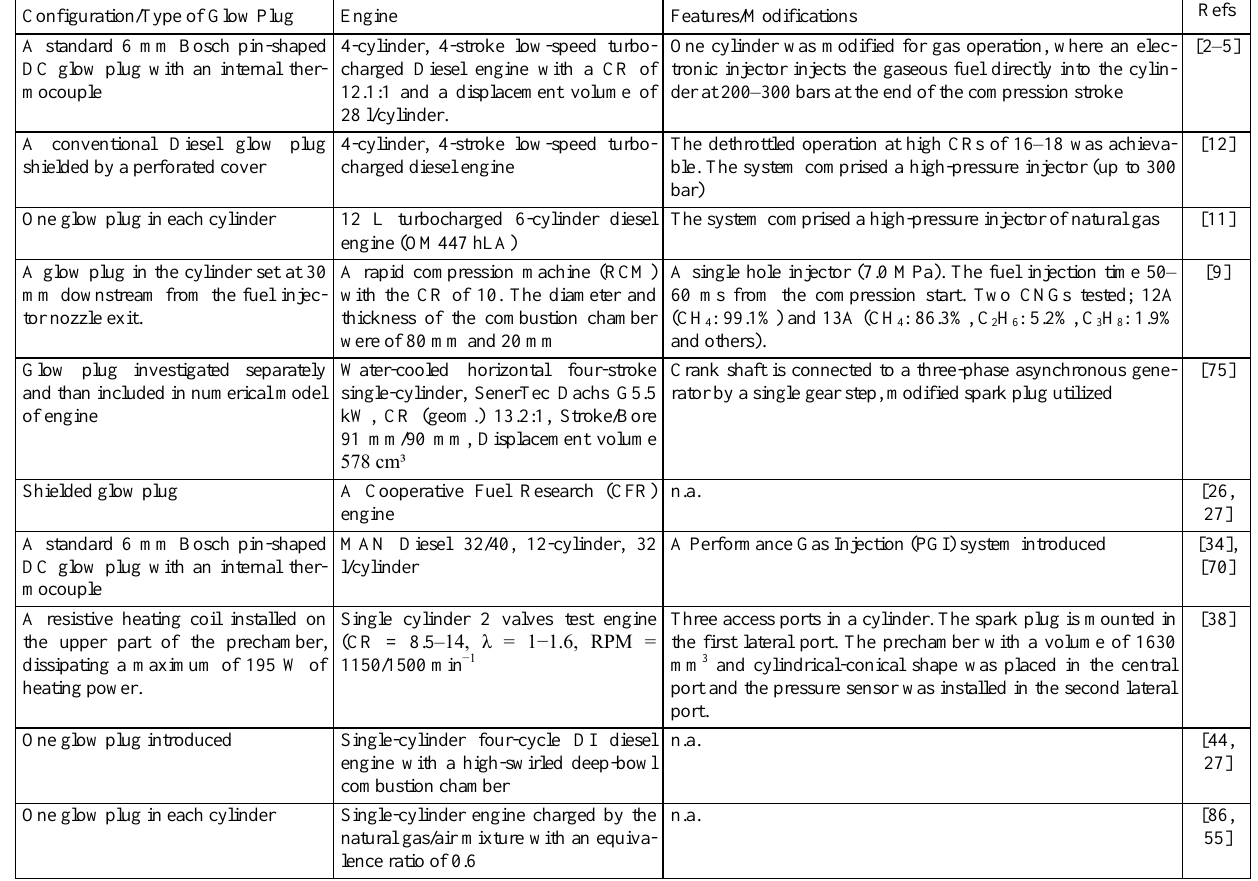
Table 3. The application of glow plugs for engines supplied with a natural